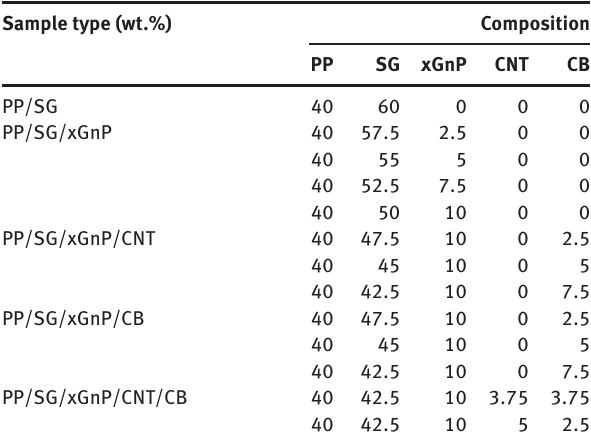
Table 2: The formulations of the different types of composites. Sample type